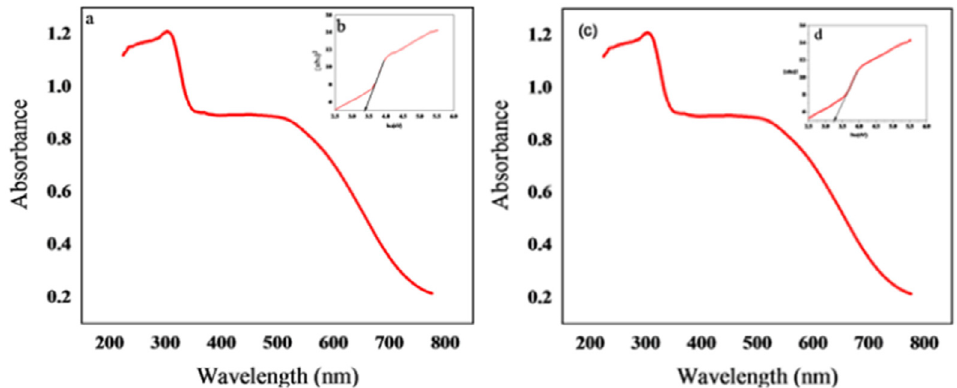
Fig. 3. UV spectrum CdSe (a) and Zr-CdSe (c) nanoparticles: Inset Tauc plot (b,